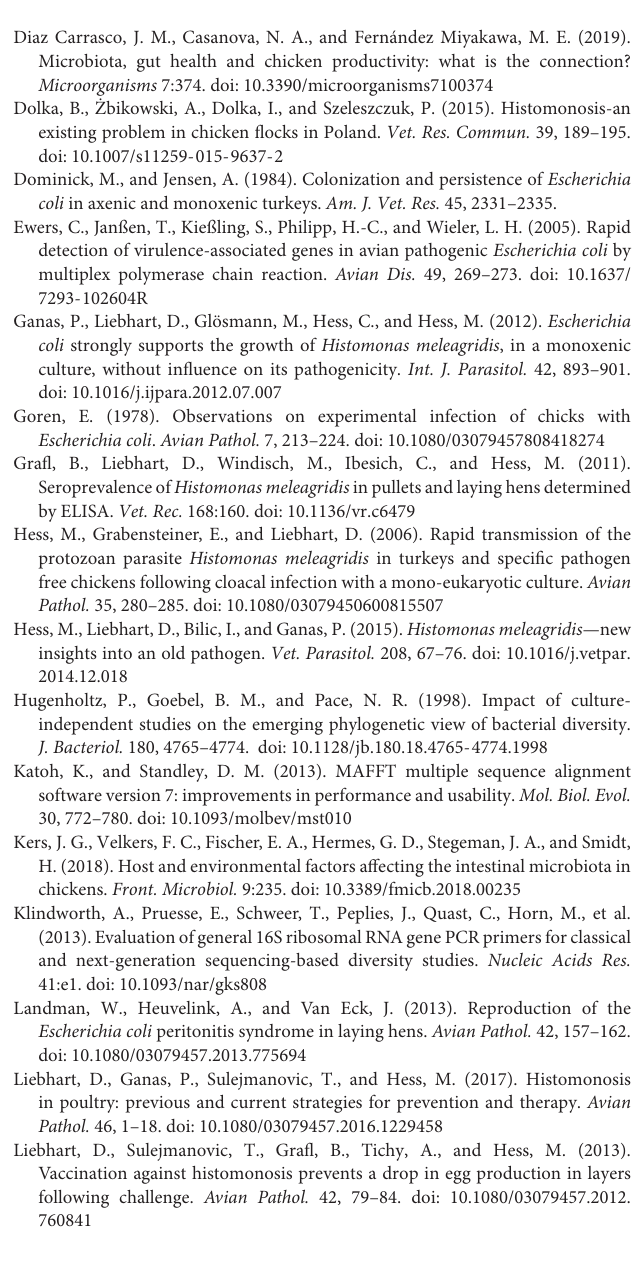
Significant difference is indicated with an asterisk. Supplementary Table 1 | Histopathology lesion scoring scheme. Supplementary Table 2 | Comparison of alpha diversity indices in caeca. Supplementary Table 3 | PERMANOVA analysis of beta diversity in